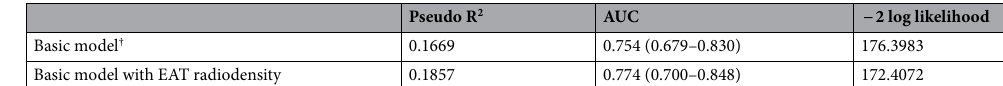
Pseudo R 2 AUC − 2 log